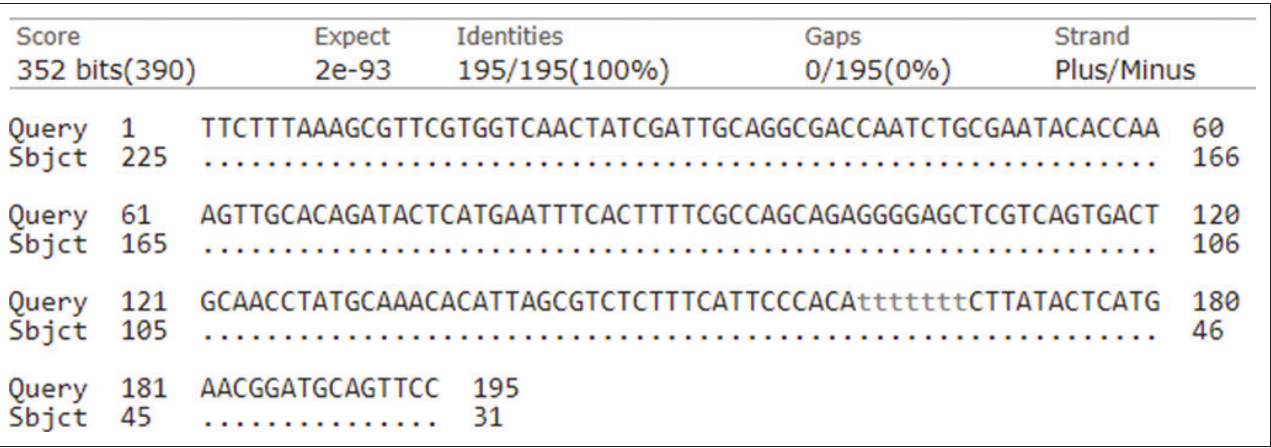
Source : Figure constructed by authors using NCBI-BLASTn online program (https://blast.ncbi.nlm.nih.gov/Blast.cgi). Sbjct, subject. FIGURE 2-A1: BLASTn result showing the alignment of T. gondii isolate (China –MK521884.1) and one sequence ( T. gondii KZN-Hlabisa isolate) obtained from the study. Nucleotide identity is represented by dots.